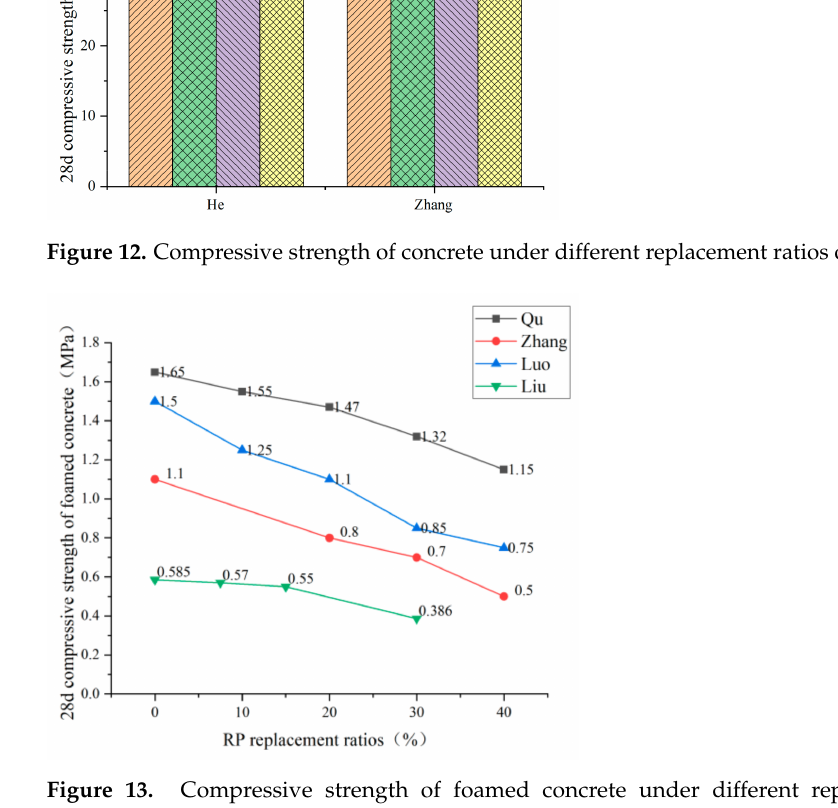
Figure 13. Compressive strength of foamed concrete under different replacement rates of RP